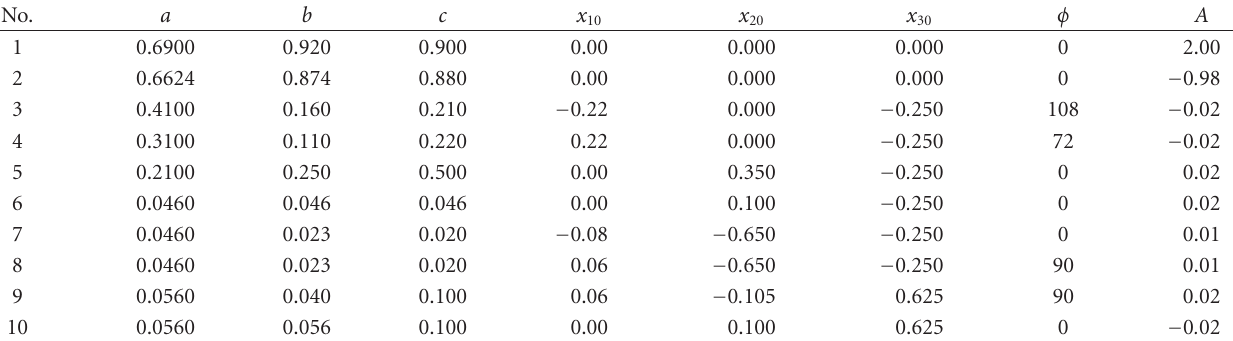
Table 3: Parameters of the low-contrast Shepp-Logan phantom.